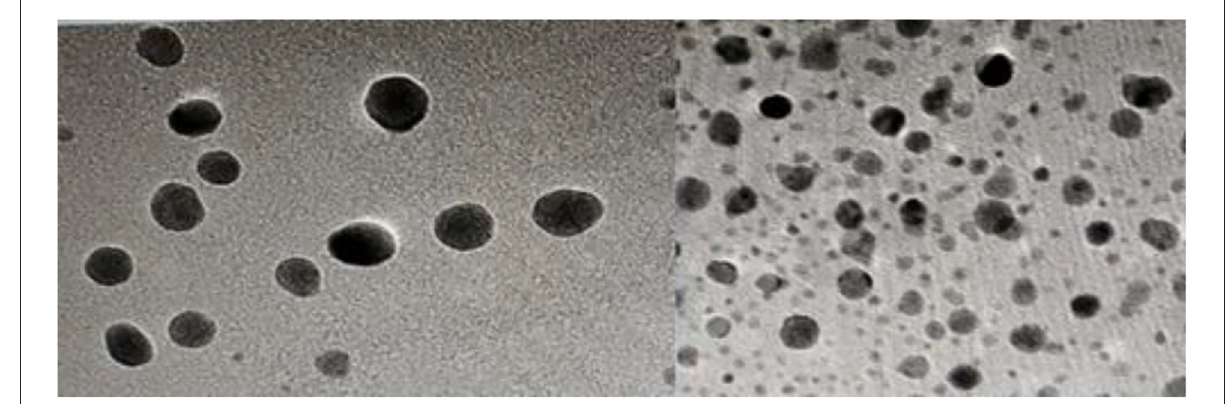
FIGURE6 TEM images of green-synthesized ZnO NP from C. ternatea .